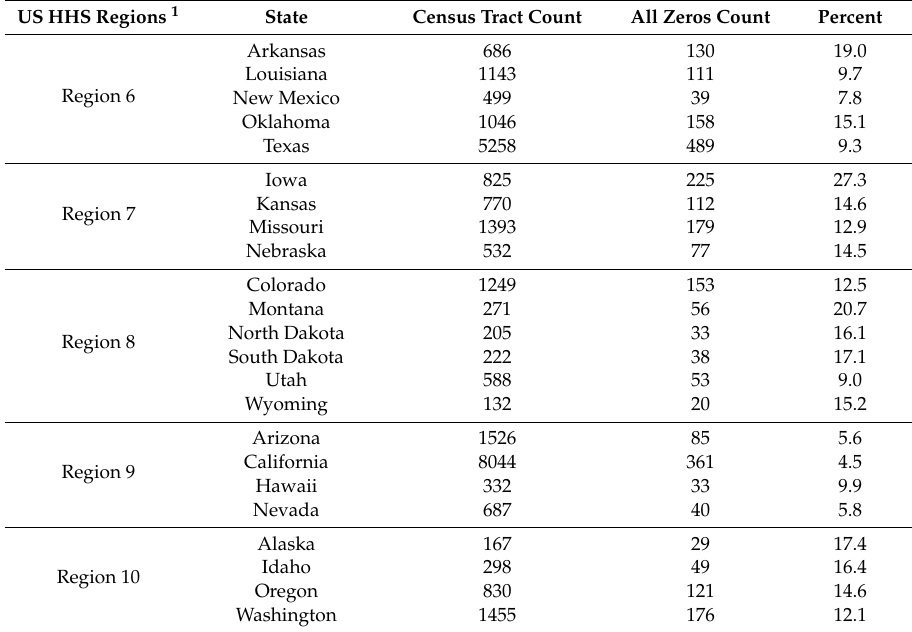
Table 3. Percentage of census tracts in rural areas not flagged for food access measures (US HHS Regions 6 through Region